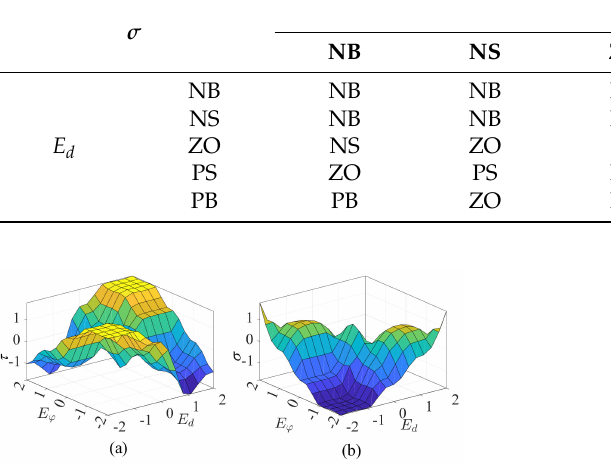
Table 2. Fuzzy rule of σ .